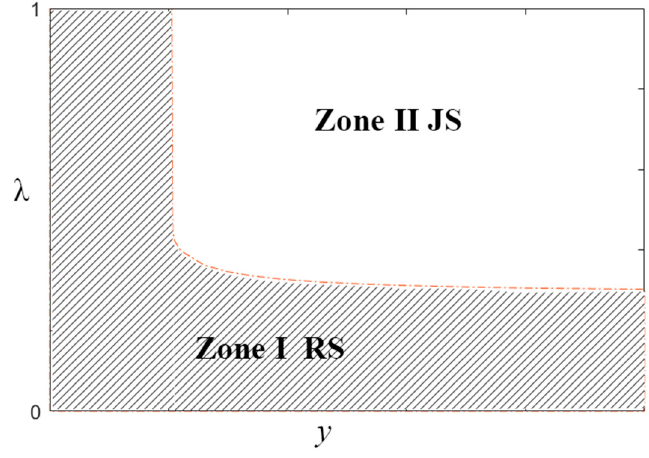
Figure 3. Pre-sale strategy selection preference of the retailer.